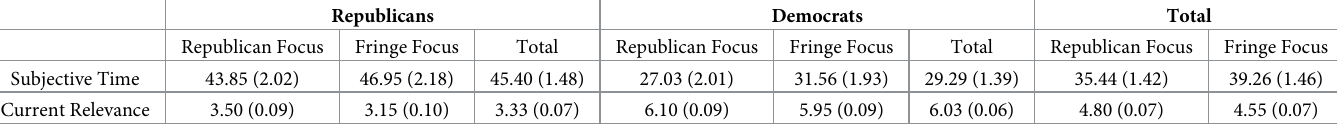
Table 8. Estimated marginal means and standard errors by cell for subjective time and current relevance.